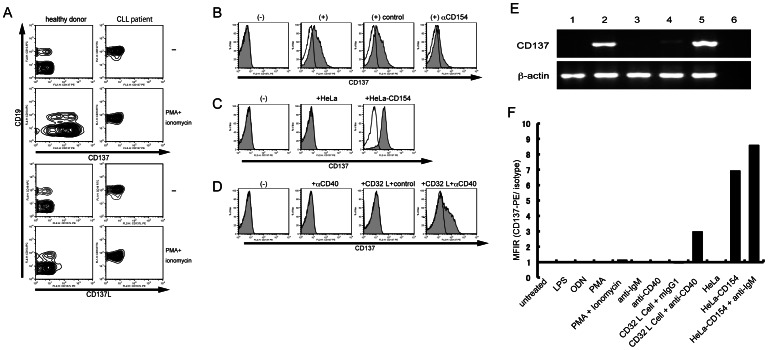
CD40 signal induces CD137 expression on B cells.(A) PBMCs from a healthy donor or a CLL patient were stimulated with or without 10 ng/ml PMA and 1 mM ionomycin for 48 h, as indicated. Cells were then incubated with anti-CD137-PE or anti-CD137L-PE monoclonal antibodies and APC-labeled anti-CD19 antibody for flow cytometric analysis. (B) CLL B cells were cultured alone (−) or co-cultured with T cells activated by magnetic beads coated with anti-CD3/CD28 antibodies (+). The blocking monoclonal antibody against CD154 or control monoclonal antibody was added in the culture, as indicated. Expression of CD137 on CD19-positive CLL cells was analyzed by flow cytometry. (C) CLL B cells were cultured alone (–) or co-cultured with HeLa control or HeLa-CD154, as indicated, for 24 h before analysis of CD137 expression. (D) CLL B cells were analyzed after being co-cultured for 24 h with or without CD32 L cells that had captured agonistic anti-CD40 or control isotype murine IgG antibody, as indicated. (E) RT-PCR was done using various samples as follows: lane 1, CLL B cells co-cultured with HeLa control cells; lane 2, CLL B cells co-cultured with HeLa-CD154; lane 3, HeLa-CD154 cells alone; lane 4, PBMCs from a healthy donor alone; lane 5, PBMCs from a healthy donor stimulated with PMA and ionomycin; lane 6, negative control without the RT reaction. After culture for 48 h, RNA was extracted by Trizol for RT-PCR analysis. RT-PCR products obtained with primers for CD137 or β-actin (as the quantitative control), are shown as indicated. (F) CLL B cells were cultured with the indicated stimulator(s). After 24 h, cells were subjected to FACS analysis. MFIR is plotted, which is calculated by dividing the mean fluorescence intensity of cells stained with a PE-CD137 monoclonal antibody by that of cells stained with a PE conjugated isotype control monoclonal antibody.